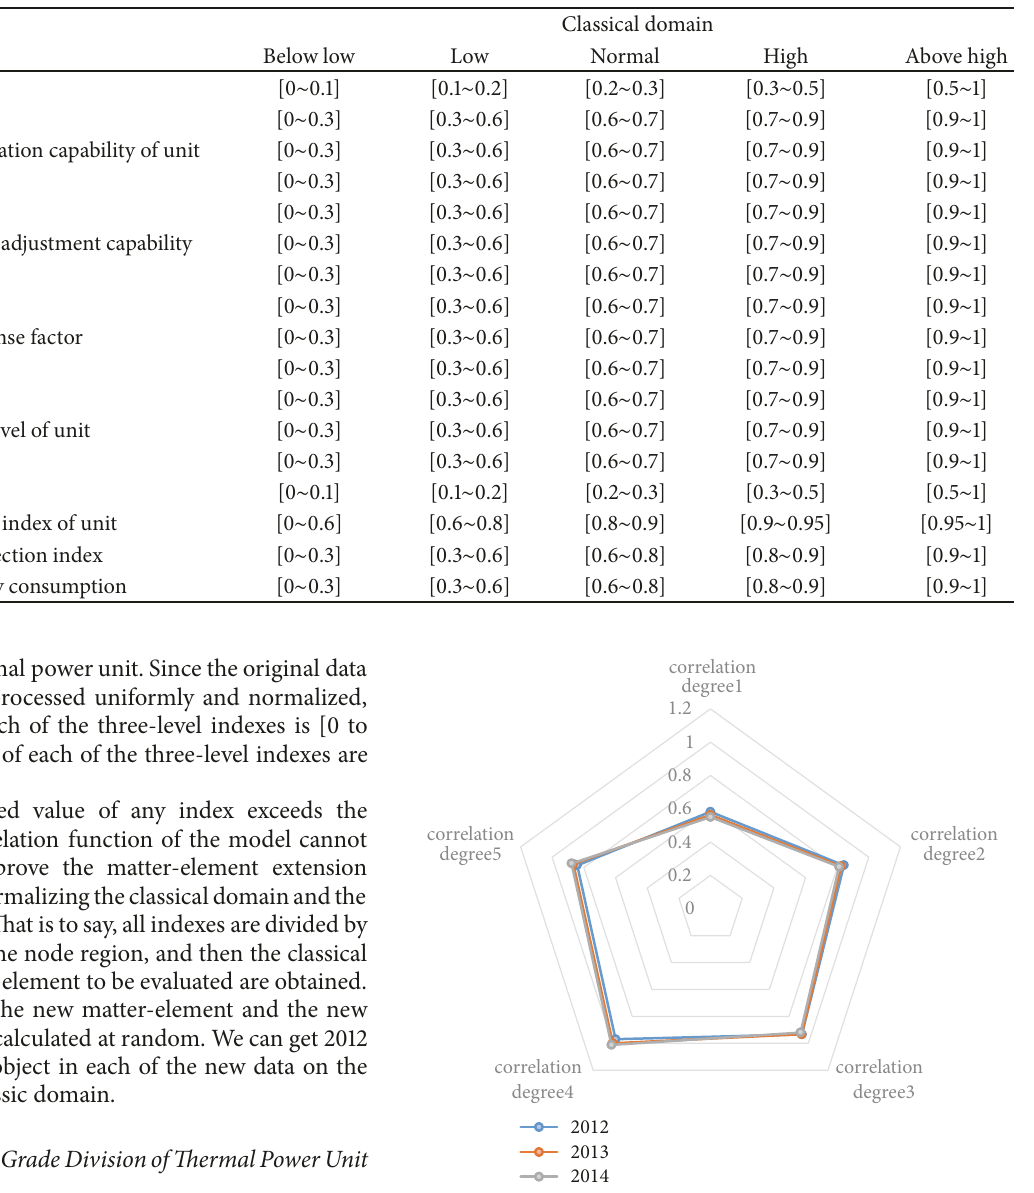
Table 3: Classical domains of the three-level indexes.